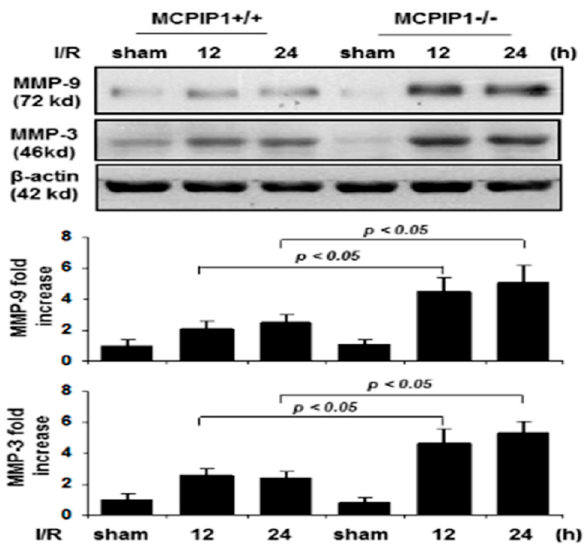
Figure 3. Altered expression of matrix metalloproteinase MMP-9 / 3 in MCPIP1 – / – mice subjected to transient focal I / R injury. Representative immunoblots analysis of MMP-9 / 3 protein levels in the mice brains after 2 h of MCAO following by 12 or 24 h of reperfusion. Protein extracts from the mice brains were subjected to immunoblot analysis with anti-MMP-9 or anti-MMP-3 antibodies, and β -actin served as a loading control ( Upper panels ). The bar graphs show the densitometric analysis of levels of MMP-9 ( Middle panel ) and MMP-3 ( Lower panel ) normalized by β -actin and expressed as fold change compared the sham-operated animals. Expression of MMP-9 / 3 was significantly higher in MCPIP1 – / – mice compared to that seen in their wild-type littermates subjected to reperfusion for 12 or 24 h after MCAO. Values represent mean ± SD, * p < 0.05 versus wild-type littermates. n = 6 per group.